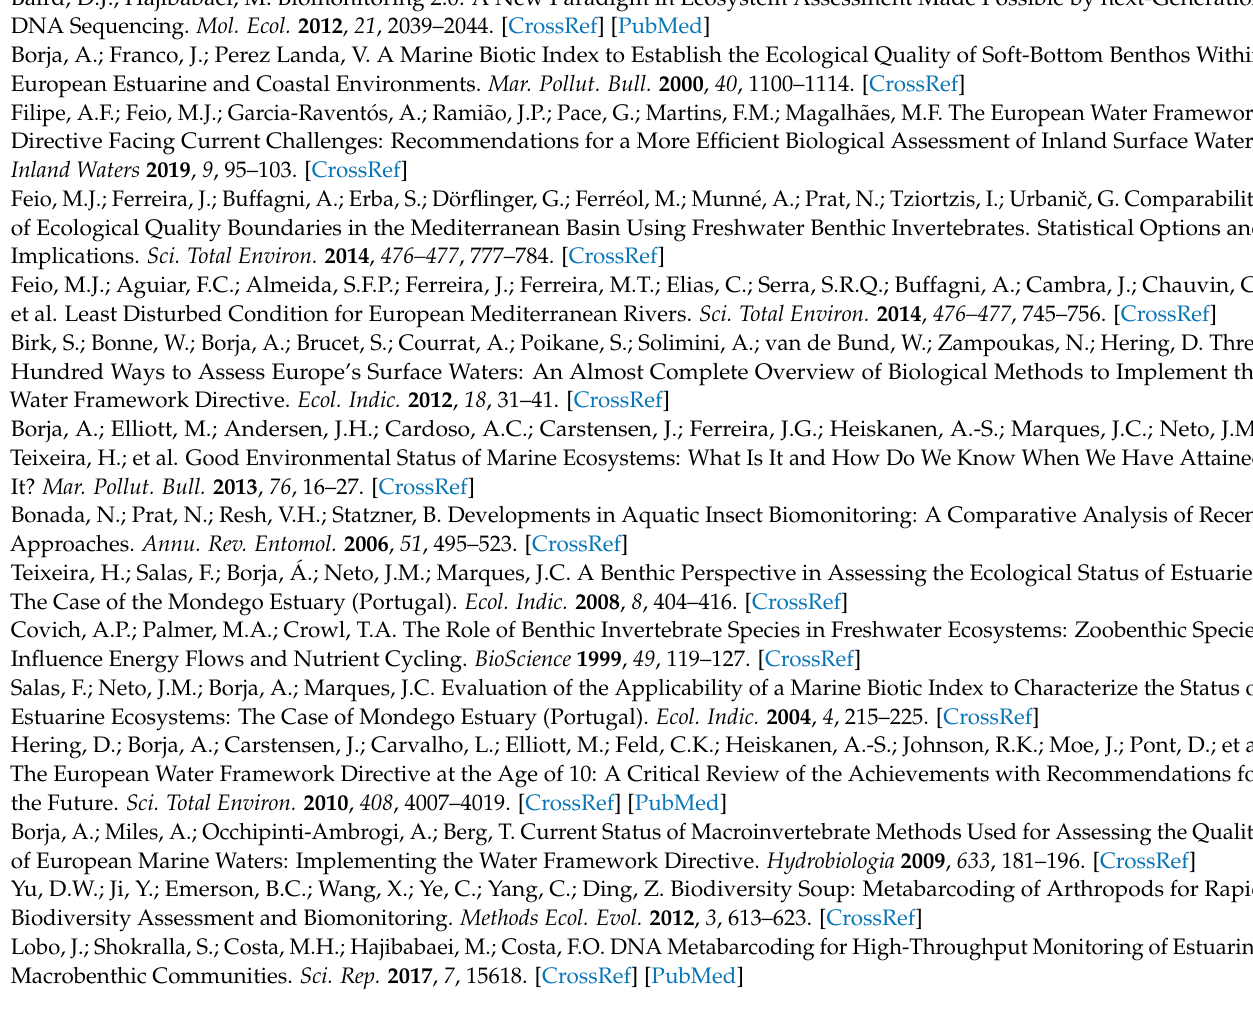
Table S2: References and information retrieved from the 90 publications employing DNA metabar- coding in aquatic ecosystems biomonitoring using benthic macroinvertebrates, Table S3: Markers loci and targeted specific regions within each locus, primer pairs, and approximate fragments length (bp) and no. of studies that used each primer pair in (F) fresh waters and (M) transitional/marine